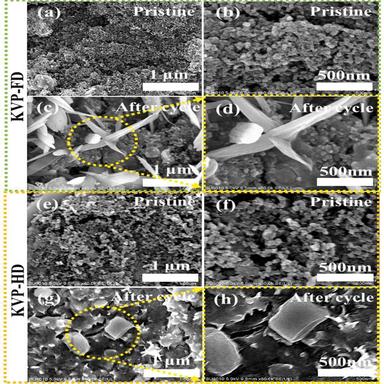
The (a-b, e-f) pristine and (c-d, g-h) post-mortem SEM of KVP-FD and KVP-HD electrodes cycled at 5C for 2000 cycles.